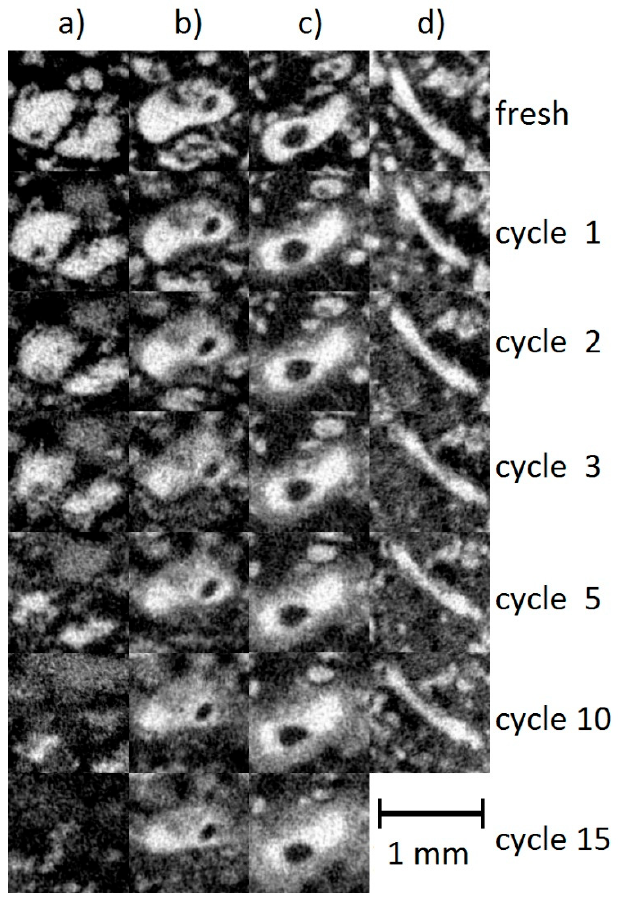
Figure 4. Overview over four selected particles in ( a ) RAM battery discharged with 100 mA, ( b ) 200 mA, ( c ) 400 mA, and ( d ) primary alkaline-manganese cell discharged with 200 mA.